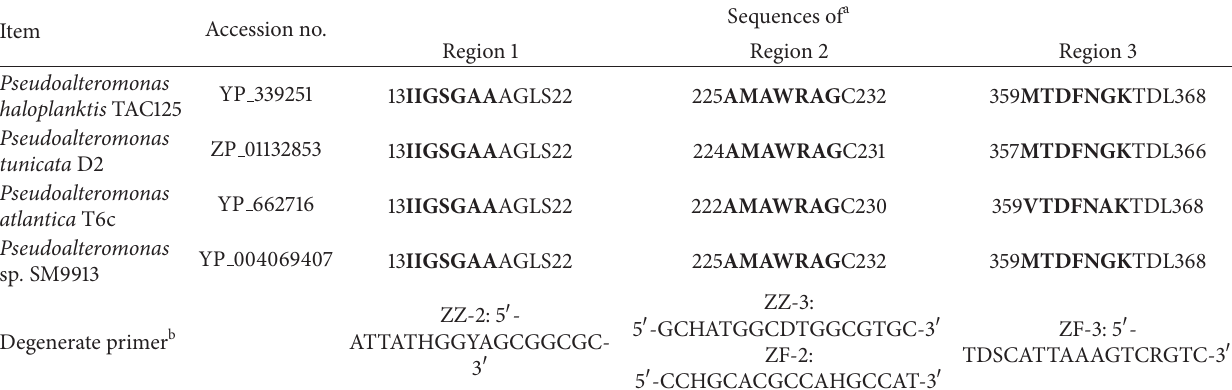
Table 2: Conserved regions of LAAOs from Pseudoalteromonas microorganisms used for design of degenerate primers. Item Accession no.